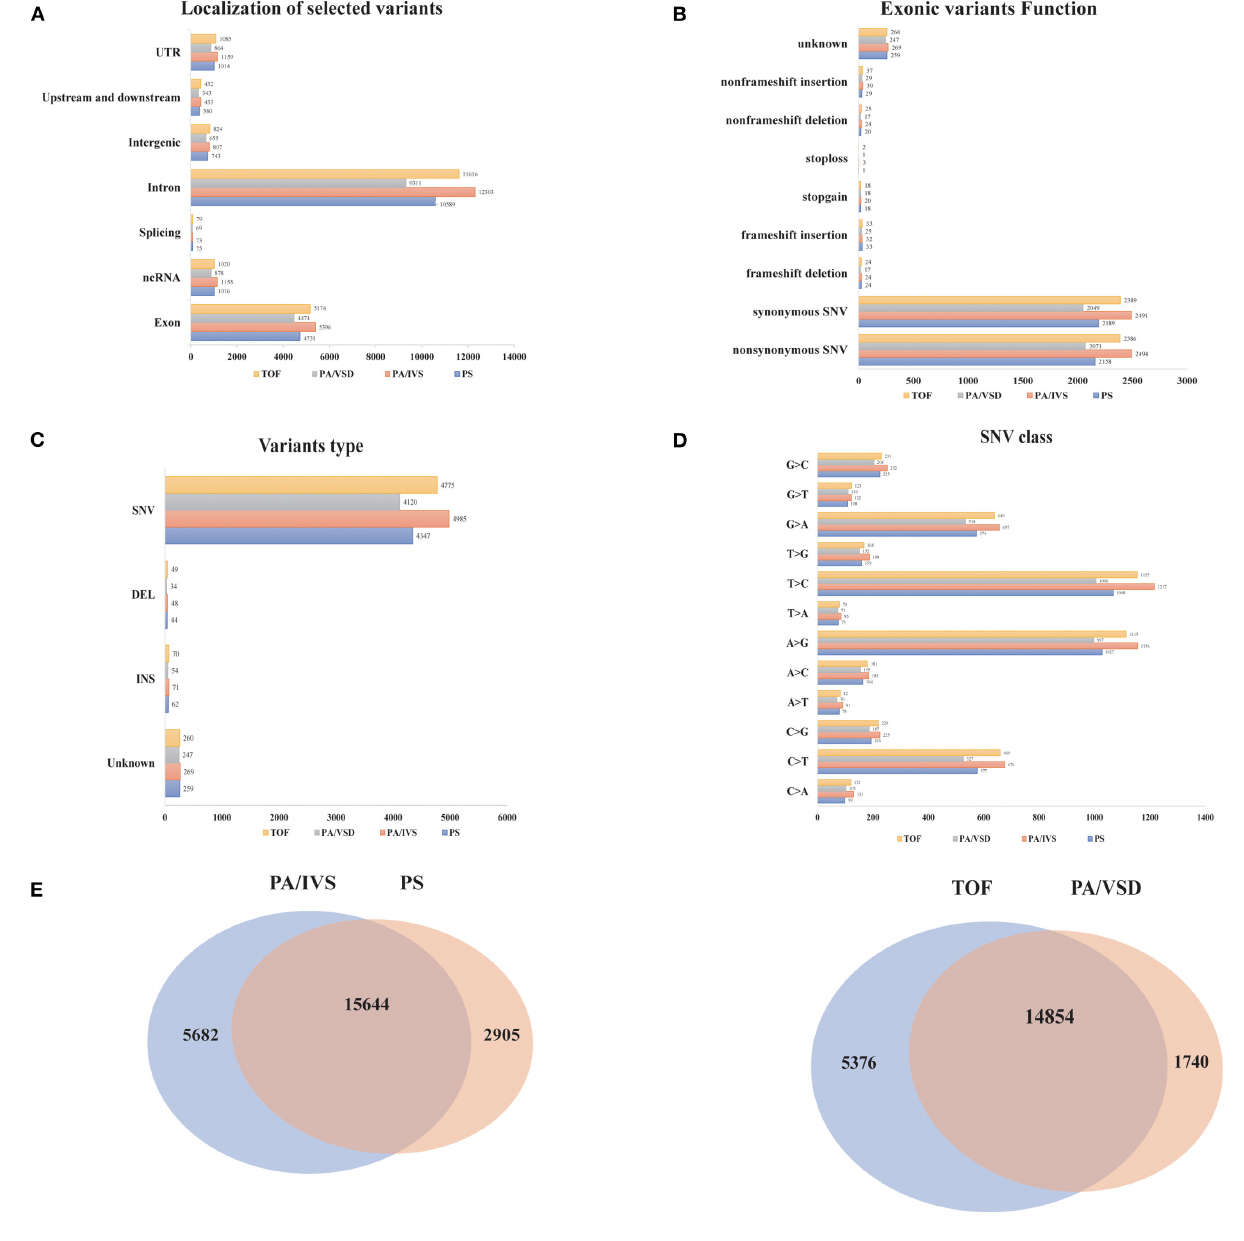
FIGURE 2 | The comparisons of the variants among four disease groups. The localization of selected variants (A) , variants type (B) , the function of exonic variants (C) , and SNV classes (D) of four diseases. (E) The comparisons of the variants between PA/IVS and PS, TOF and